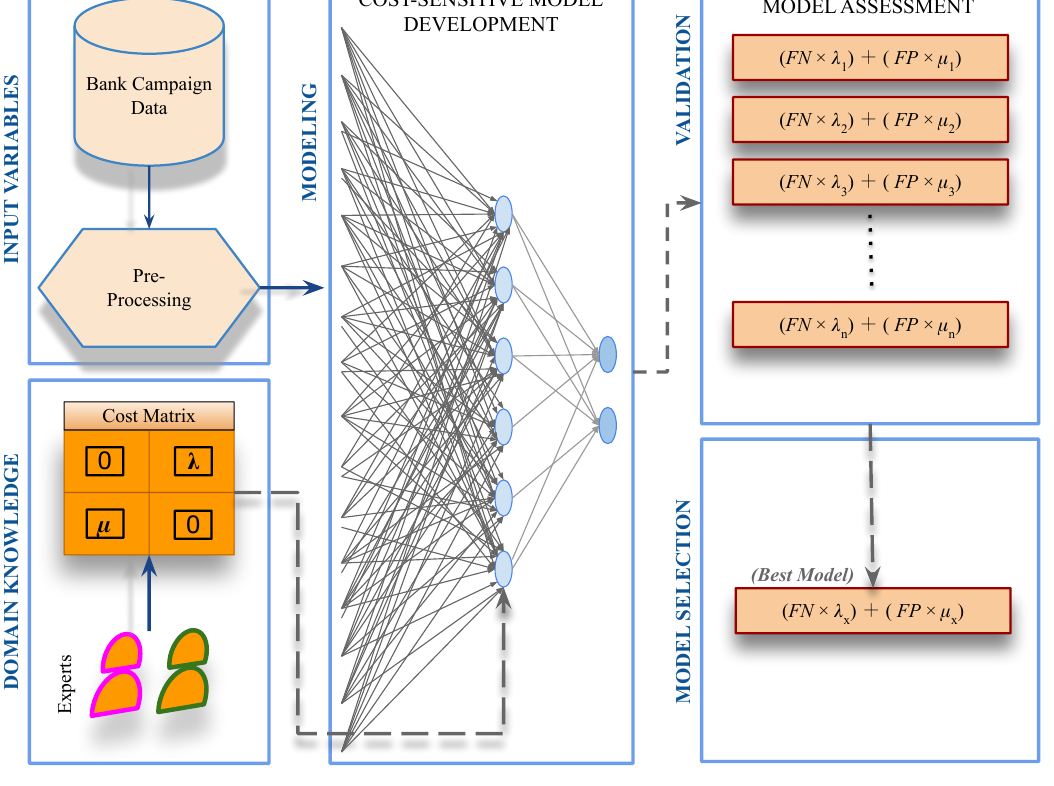
Figure 2. The Proposed